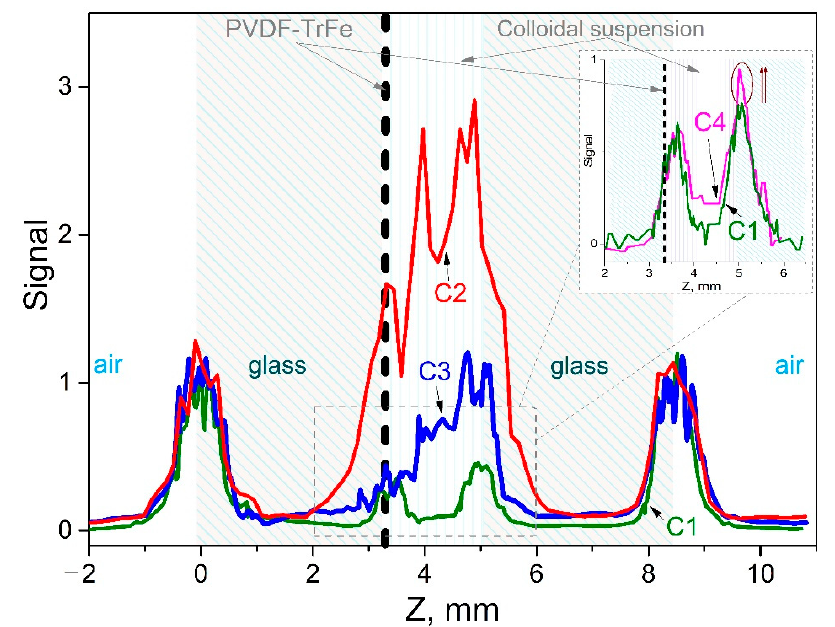
Figure 7. Experimental data of the TH signal measured by scanning the interface of the flow cell with different concentrations (see Table 1). C1—ethanol, C2—ZnO HNPs in ethanol (~1 mg/mL), C3—ethanol in cell after ~30 min of measurements with ZnO HNPs colloidal suspension. The insert shows the comparison of the initial ethanol response C1 and C4—ethanol after 30 min of measurements with lower concentration (~0.1 mg/mL) of ZnO HNPs colloidal suspension.